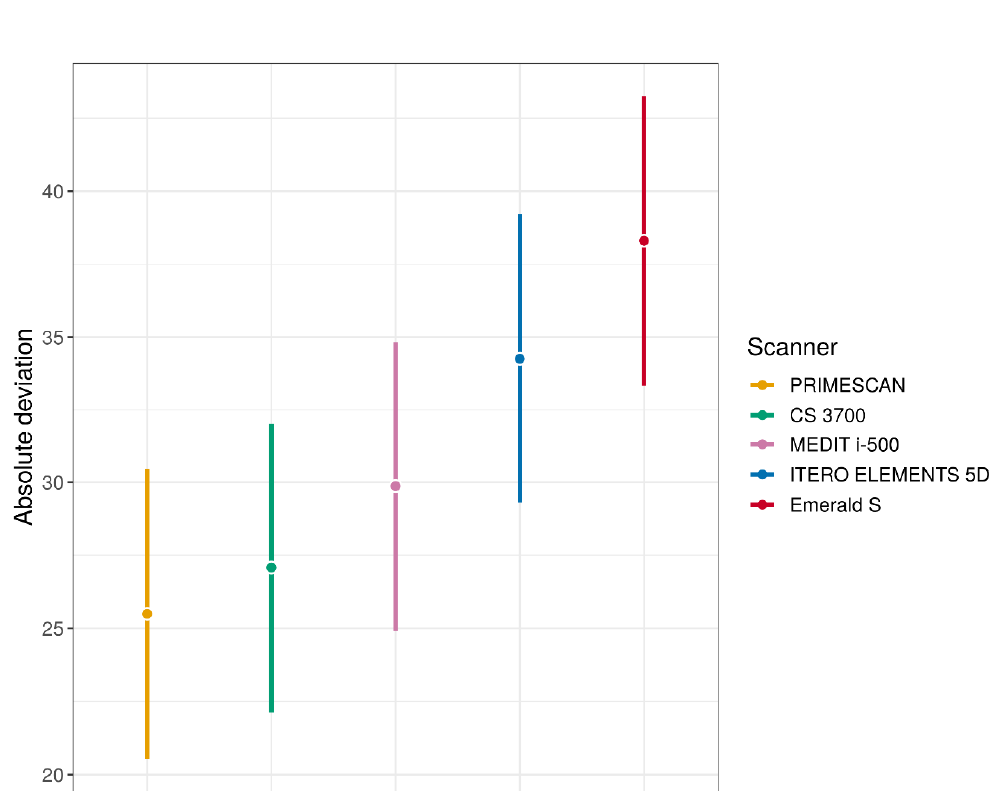
Figure 5. Mean absolute deviations estimates (with 95% confidence interval (CI)) for each type of IOS (these quantities were estimated using linear mixed effects model).